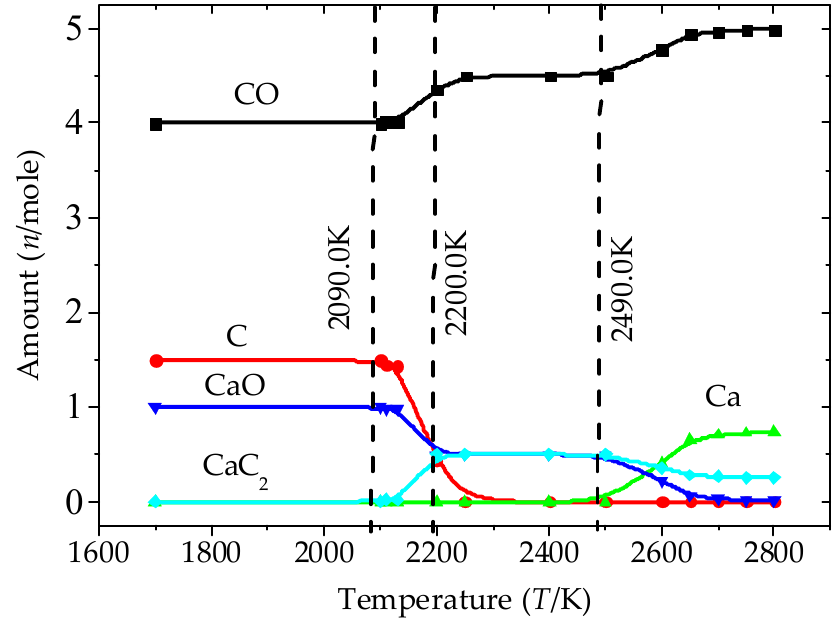
ChemEngineering 2020 , 4 , x FOR PEER REVIEW Figure 17. The equilibrium composition at each reaction temperature. Figure 17. The equilibrium composition at each reaction temperature.